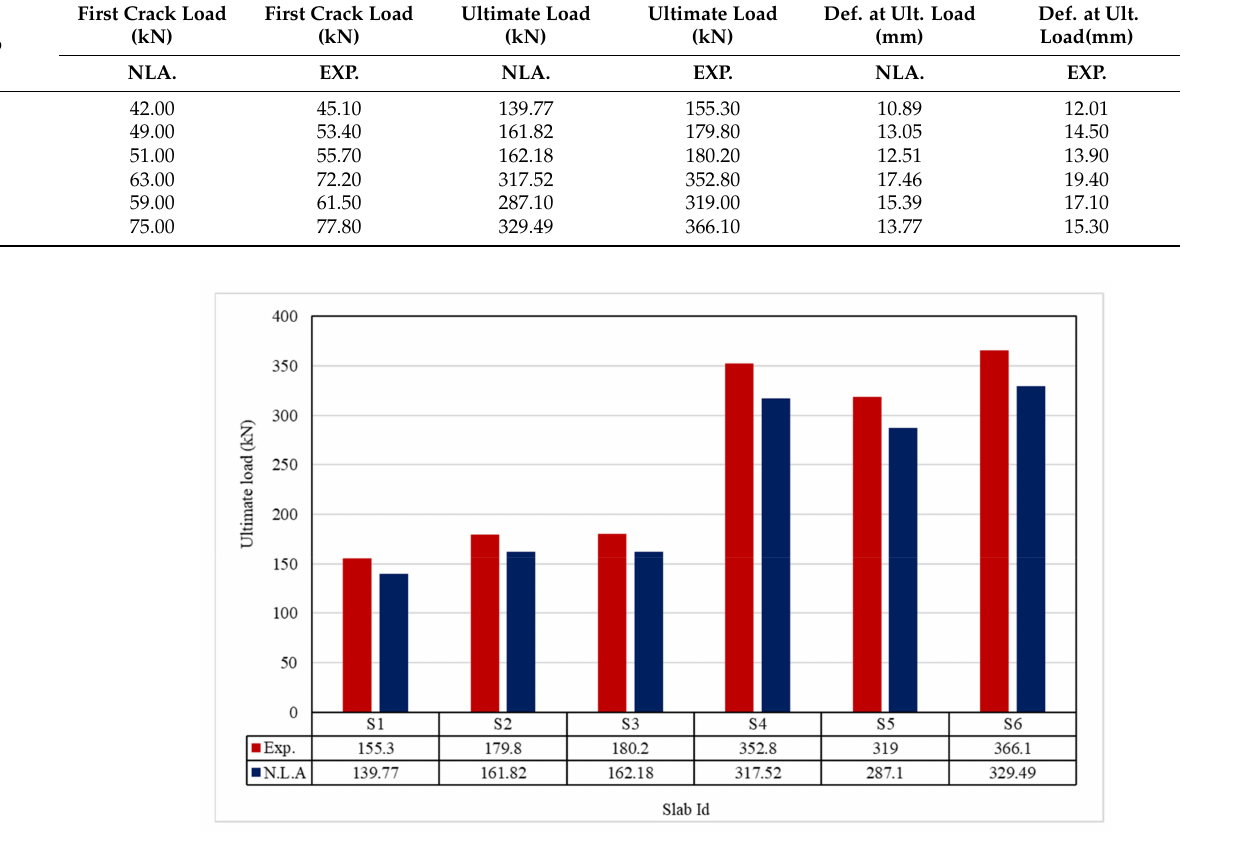
Figure 24. Comparison between Exp. and NLA ultimate loads.